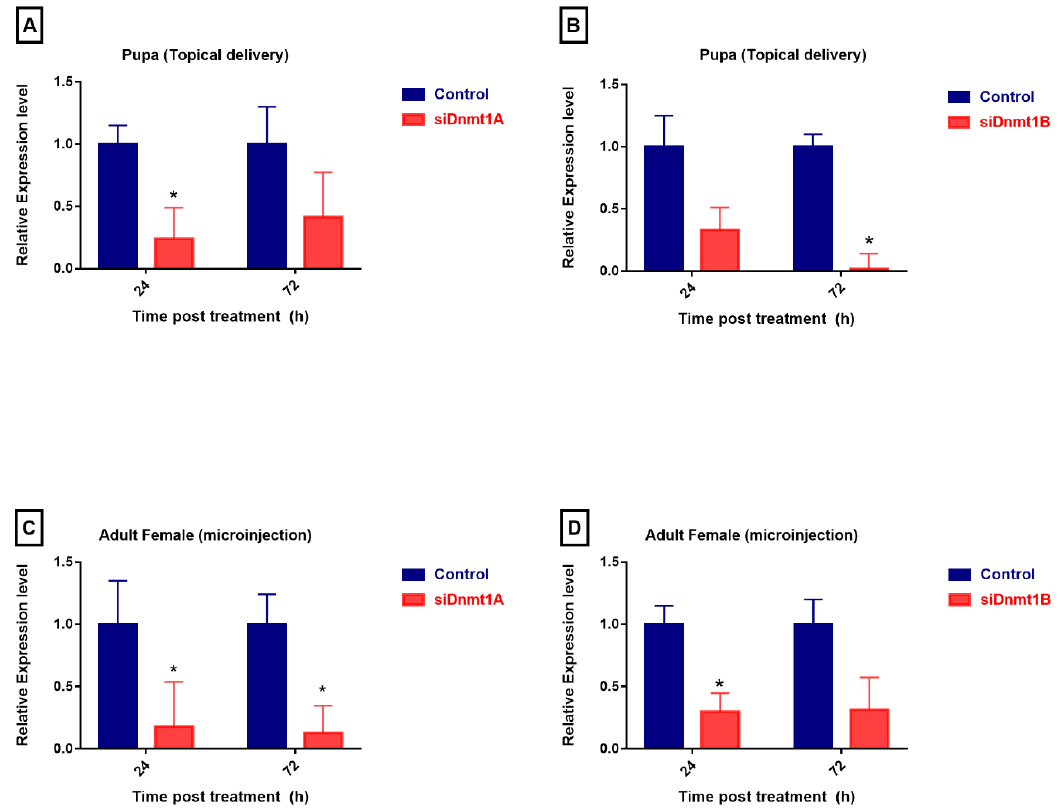
Figure 3. Relative mRNA levels of the two DNMT genes in pupae and adult females of P. solenopsis following topical delivery and microinjection with small interfering RNAs (siRNAs). At 24 h and 72 h post-treatment, the mRNA levels of PsDnmt1A and PsDnmt1B were significantly decreased compared with the control. Relative expression was normalized as mean ± SE with three biological replicates and analyzed using Student’s t -test (* p < 0.05).